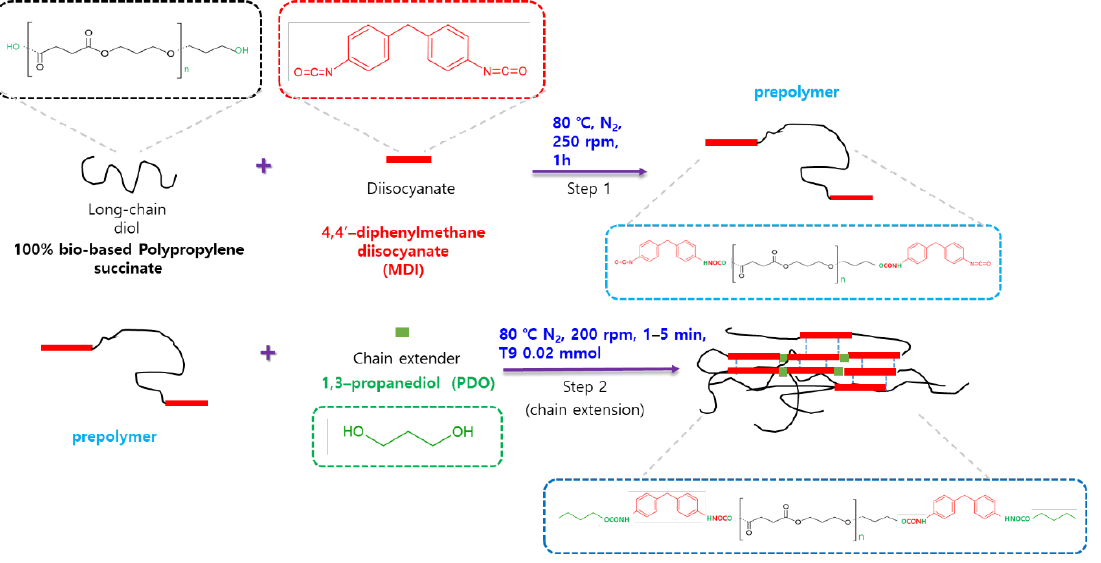
Figure 1. Synthetic scheme outlining preparation of the bio-based SMTPU via the two-step prepol- ymer process.